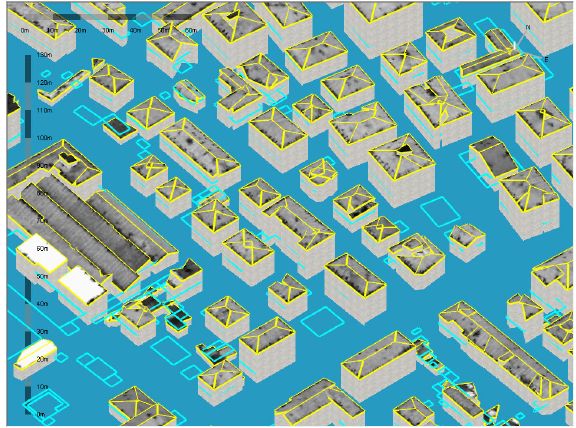
Figure 6: Possible error highlighted with a yellow triangle, Or- thometric Height from CTC in green, calculated Geoid Height in red